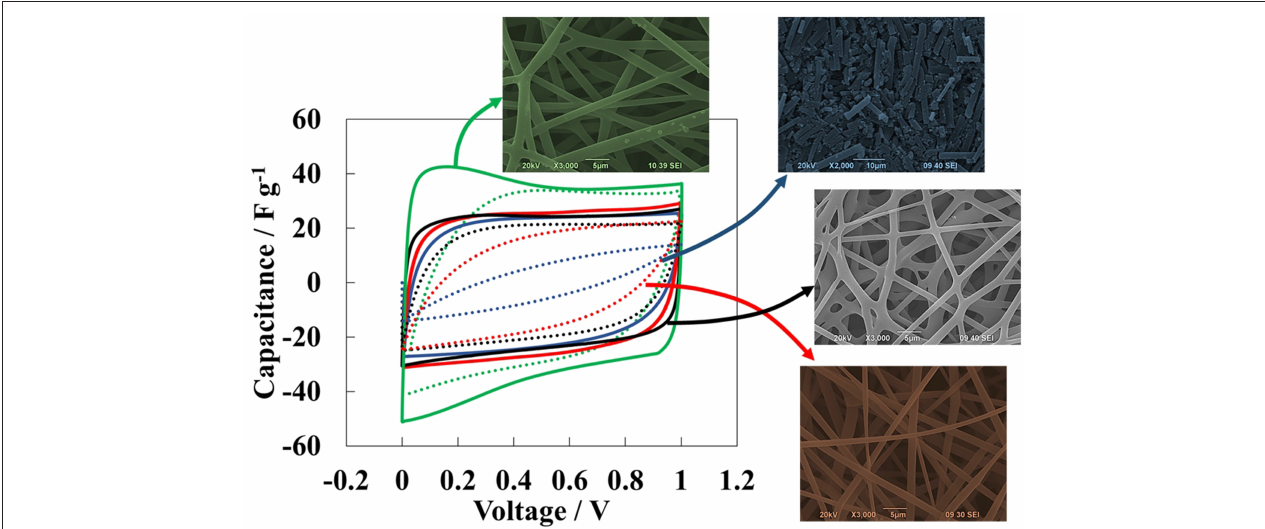
FIGURE 8 | Cyclic voltammetry at 0.1 (solid lines) and 1.0V s − 1 (dashed lines) of 2-electrode supercapacitor cells using milled carbon papers electrodes prepared using PTFE as binder and a carbon black as conductivity promoter (blue lines); self-standing carbon paper electrodes (red lines); self-standing and interconnected carbon paper electrodes (black lines); self-standing and interconnected carbon paper electrodes carbonized in 1% air (green